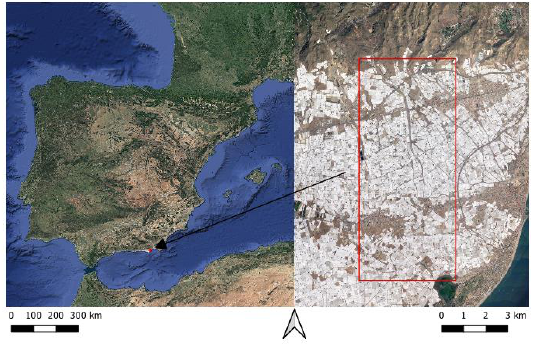
Figure 1 . Location of the study